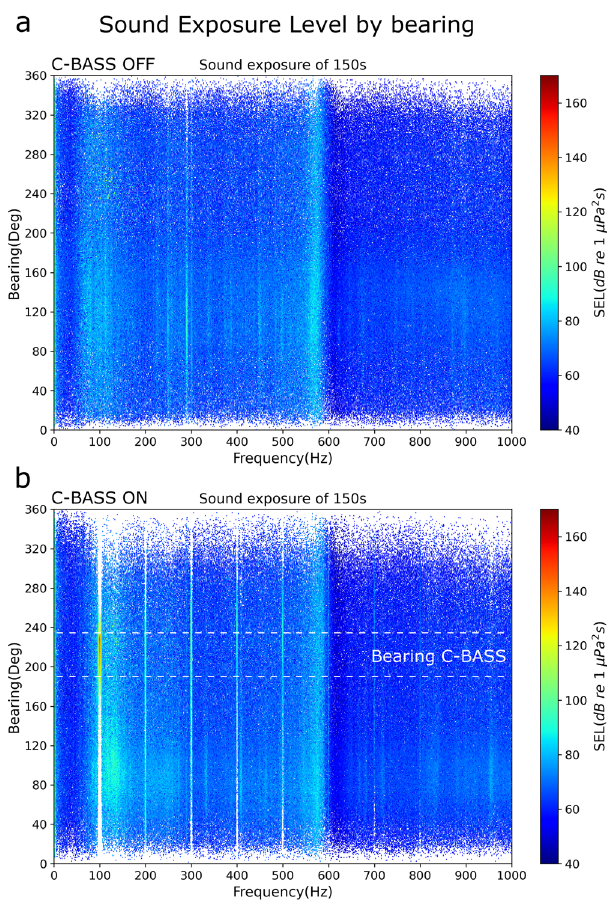
Fig. 5 Sound exposure level (SEL) across frequencies and bearing measured by the M20-110 acoustic vector and sound pressure sensor. The bearing is of 1-degree resolution and the frequency is of 1 Hz resolution. The processing parameters are: segment time length of 1 s, 80% overlap, fast Fourier length of 20,000, and Hann window. a Ambient SEL (dB re 1 μ Pa 2 S) from the acoustic pressure channel of the M20-110 displayed by bearing and frequency when the C-Bass speaker was turned off. b SEL from the acoustic pressure channel of the M20-110 displayed by bearing and frequency when the C-Bass projector was turned on. The horizontal dashed lines highlight the approximate bearing of the sound source (C-Bass) relative to the acoustic vector